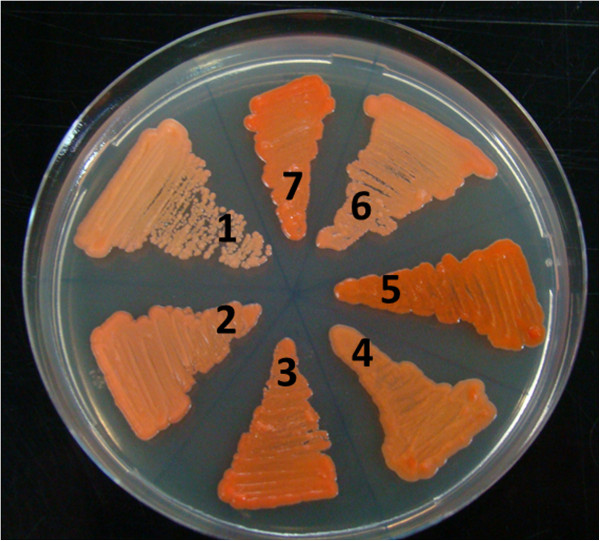
Color phenotype of cyp61 mutant and wild-type strains. Cultures in solid YM complete media of strains UCD 67–385 (1), 385-CYP61/cyp61hph (2), 385-cyp61hph/cyp61zeo (3), AVHN2 (4), Av2-cyp61zeo (5), CBS 6938 (6) and CBS-cyp61hph (7).